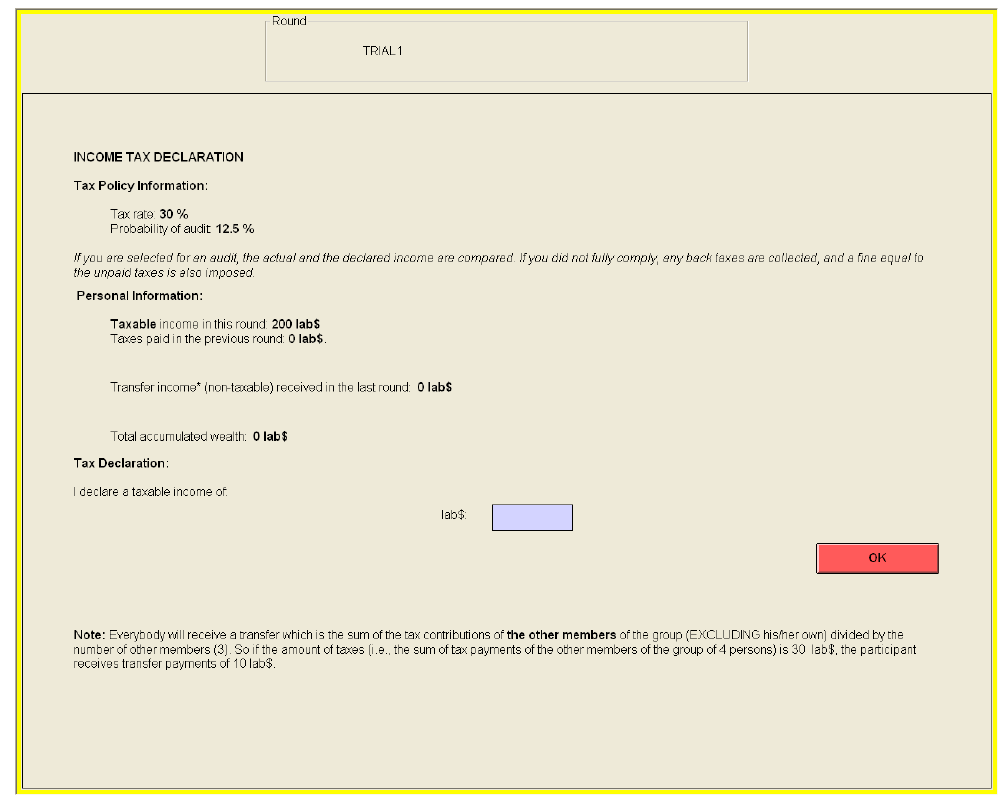
Figure 1. Income Tax Declaration (see [13], p. 17).